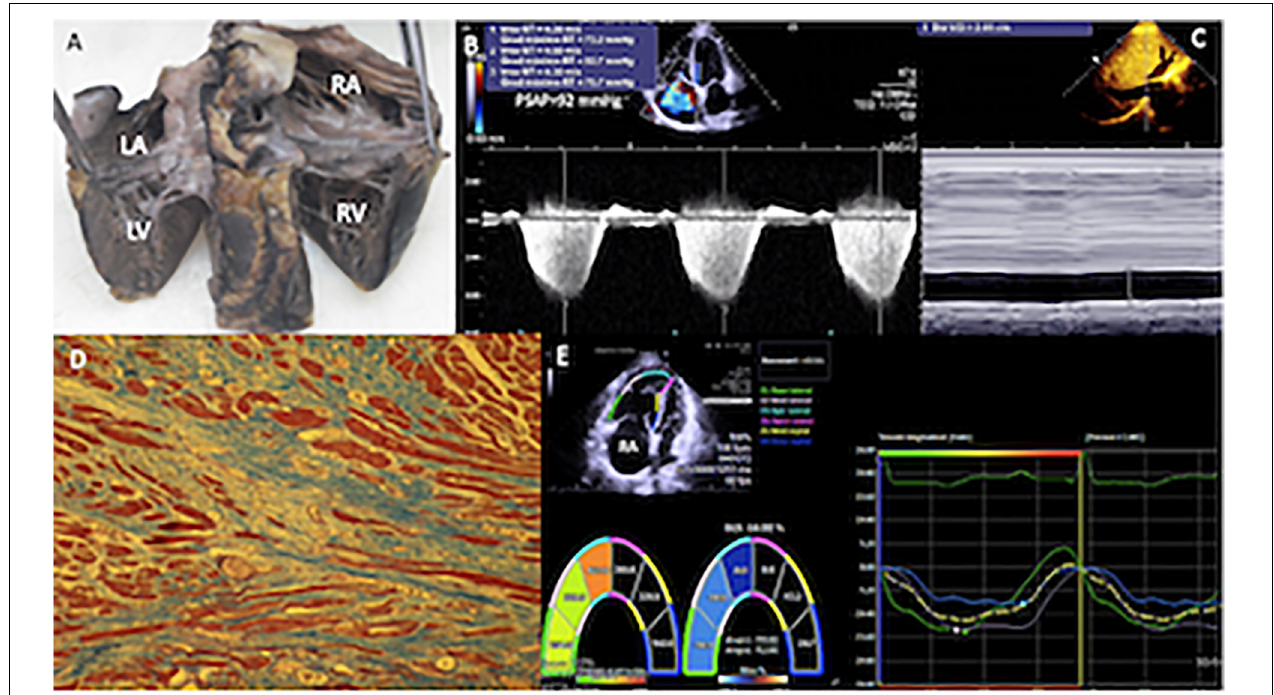
FIGURE 3 | (A) Specimen of the heart of a patient with sPAP of 90 mmHg. Heart cut longitudinally from the atria to the ventricles (entry routes through the posteroinferior aspect) that allow to appreciate the dilation of the right cavities. (B) Two-dimensional echocardiogram with Doppler in the apical four-chamber view, with severe tricuspid regurgitation, by means of which an average gradient of 77 mmHg was calculated. (C) In the subcostal plane, the dilatation of the inferior vena cava (29.1 mm) and collapse of < 50% were detected, calculating a right atrial pressure of 15 mmHg. (D) The histological study of right ventricular myocardium, most of the muscle fibers are in longitudinal section in red and the fibrous tissue rich in collagen fibers is observed in blue, it extensively replaces the muscle fascicles, and, in this image, it reaches 75% or three quarters. The muscle fibers embedded in the fibrous connective tissue appear elongated and thinned. Masson 10 × . (E) The global longitudinal strain of the right ventricle, using velocity vector imaging was − 14%, in a patient with a high probability of PH (sPAP = 92 mmHg). RA, right atrium; RV, right ventricle; LA, left atrium; LV, left